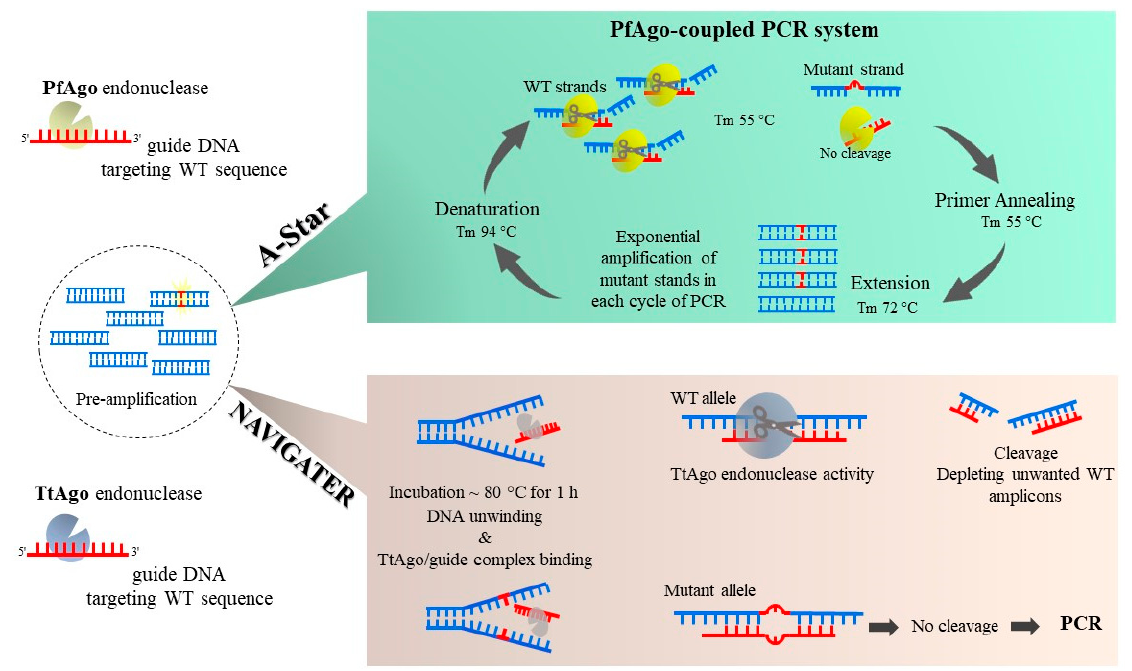
Figure 3. A-Star and NAVIGATER methods enable enzymatic mutation detection that does not require the presence of a specific motif site near the mutation site. The A-Star method uses a thermostable PfAgo enzyme, that makes a complex with guide DNA (gDNA) that matches WT strand sequence. PfAgo-coupled PCR reactions are performed to cleave WT strands repeatedly during PCR cycling and subsequently increase mutant strands exponentially. In the Nucleic Acid enrichment VIa DNA-Guided Argonaute enzyme (NAVIGATER) method, from Thermus thermophilus, WT alleles are detected and cleaved using Tt Ago and a gDNA to bind complementary WT strands. Following an initial pre-amplification step, the amplicons unwind during incubation at ~80 °C and provide the chance for Tt Ago/guide complexes to attach to WT alleles. Tt Ago detects fully matched WT/gDNA hybrids while sparing mismatches caused by mutations. A subsequent PCR reaction amplifies mutated alleles preferentially, and these are detected via subsequent detection methods.